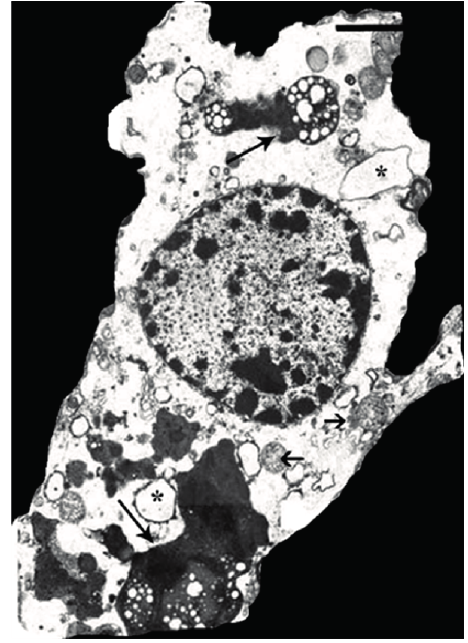
Figure 6. Hippocampal astrocyte pathology in human schizophrenia. Note the presence of swollen mitochondria (short arrows), distended cytoplasmic vacuoles (asterisks) and abundant autophagic material/lipofuscin (long arrows). Bar = 2 µm. Compare with cytopathology of HMOX1 -transfected rat astroglia (Figure 3) and astrocytes of GFAP.HMOX1 transgenic mice (Figure 5). (From [22], with